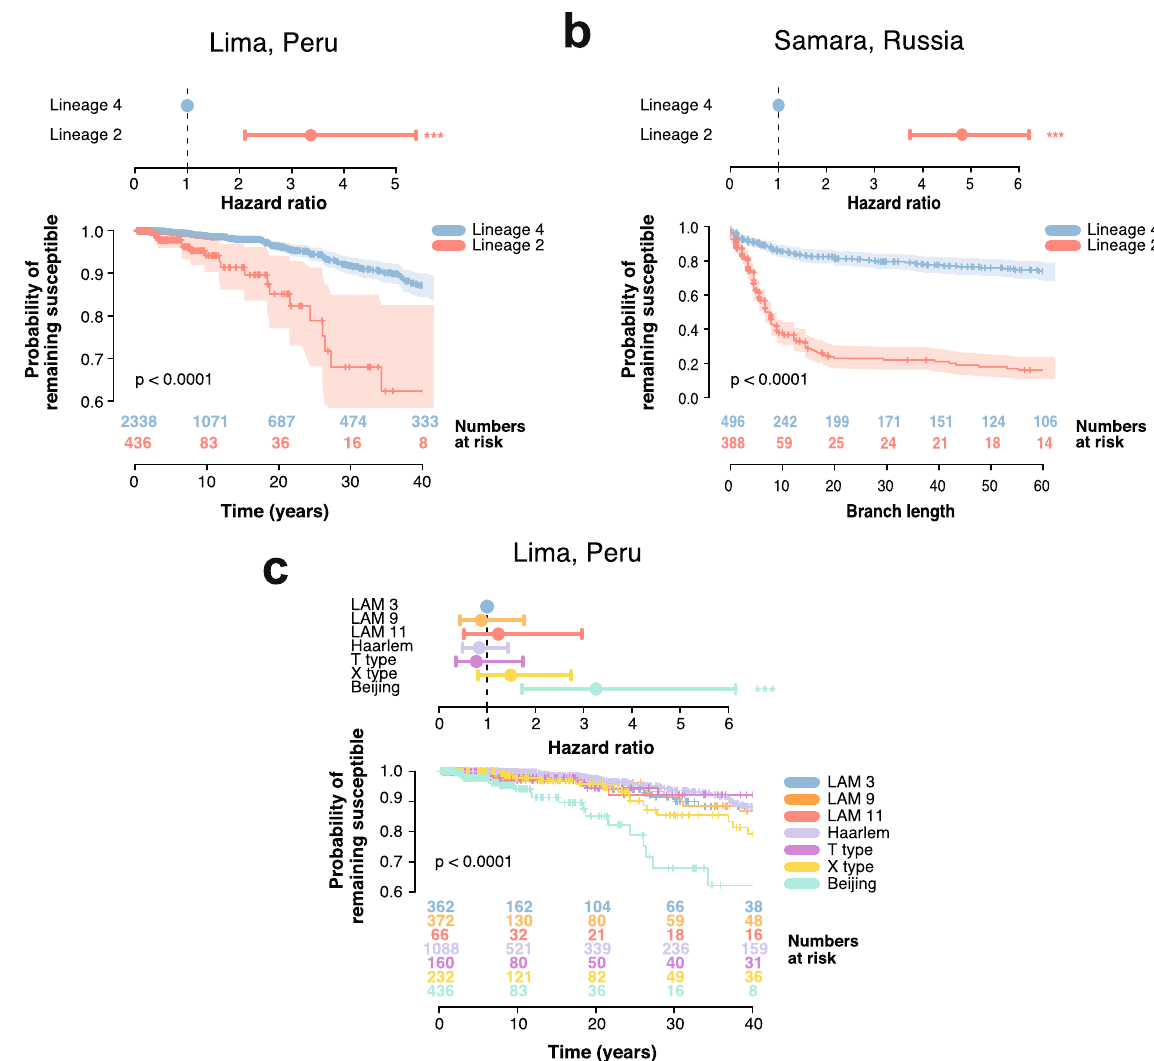
Fig. 5 Hazard ratio and Kaplan – Meier curve for different sublineages of Mycobacterium tuberculosis . a – c Top: Hazard ratio (HR). Points and error bars represent the HR estimate and the 95% CI, respectively. The p -value for the HR was calculated using the likelihood ratio test. Bottom: Kaplan – Meier curve and numbers at risk. Y-axis represents the probability of remaining susceptible to any antibiotic, while the X-axis shows the time in years or the distance in branch length. Shaded areas show the 95% CI. Kaplan – Meier curves were compared and p -values were derived using the log-rank test. a Depicts the HR of lineage 2 compared to lineage 4 in the Peruvian dataset (HR 3.36, 95% CI 2.10 – 5.38, Likelihood ratio test p -value = 4.25 × 10 − 7 ) and the different Kaplan – Meier curve for lineage 2 and lineage 4 (Log-rank test p -value = 1.2 × 10 − 9 ). b Same metrics for the Samara dataset (HR 4.82, 95% CI 3.74 – 6.21, Likelihood ratio test p -value = 6.8 × 10 − 34 ; Kaplan – Meier curve Log-rank test p -value = 1 × 10 − 39 ). c Shows HR between lineage 2 and the different sublineages of lineage 4 found in the Peruvian dataset (LAM9, LAM3, LAM11, Haarlem, X type and T type), using LAM3 as a reference (lineage 2 HR 3.32, 95% CI 1.84 – 6.28, Likelihood ratio test p -value = 1.9 × 10 − 4 , all other p -values > 0.2; Kaplan – Meier curve Log-rank test p -value = 6.9 × 10 − 8 ). Statistical signi fi cance of the hazard ratio differences presented next to the CI bars (* p < 0.05; ** p < 0.01; *** p <